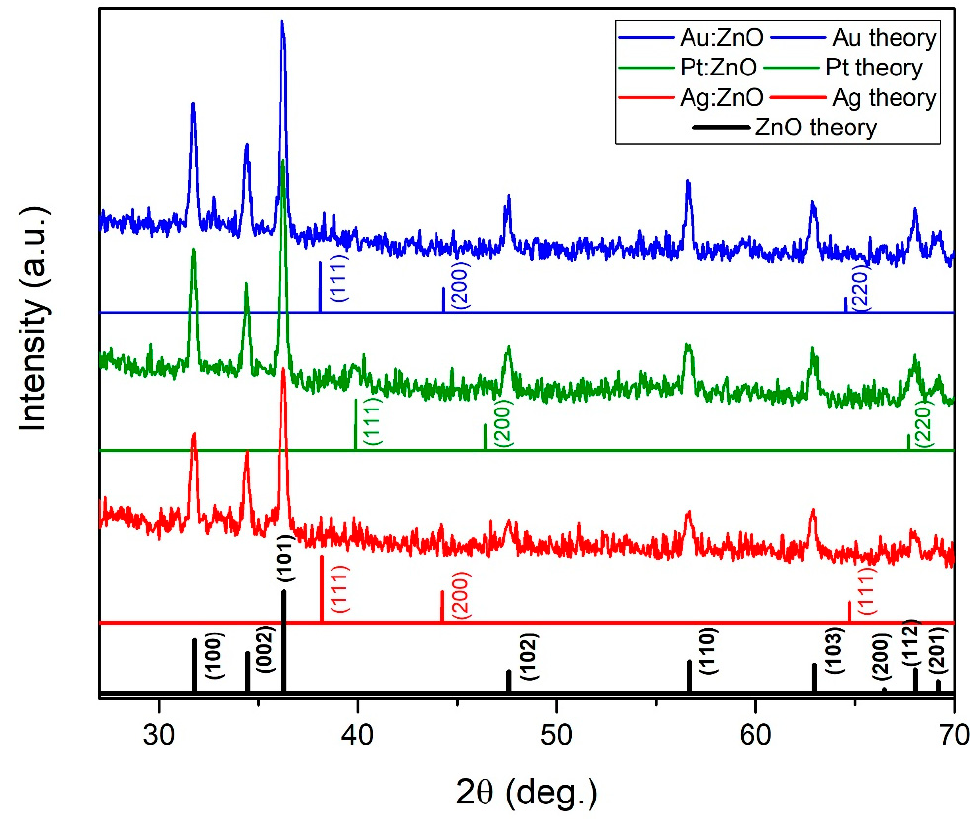
Figure 4. X-ray diffraction patterns of the Ag, Au, and Pt doped ZnO nanoparticles. We observed shifts in the peaks of the hexagonal wurtzite structure (Figure 5) into smaller angles for the Ag: ZnO, Au: ZnO, and Pt: ZnO compared to the pure ZnO. These average shifts were 0.26 ◦ for Ag: ZnO, Au: ZnO, and Pt: ZnO. These shifts toward the smaller angles are attributed to the larger ionic radii of Ag + (1.15 Å), Au + (1.37 Å), and Pt 2+ (0.8 Å) than Zn 2+ (0.74 Å), which implies that Ag + , Au + , and Pt 2+ substituted fraction of Zn 2+ ions in the ZnO lattice. The sum of ionic radii (Ag + O, Au + O, Pt + O) is greater than the sum of ionic radii of Zn and O. Also, the bond lengths of Ag-O, Au-O, and Pt-O are longer than Zn-O in a hexagonal structure. This means that the unit cell should expand, and consequently, XRD peaks shift towards smaller angles. Similarly, Anugrahwidya et al. reported a shift in the main peak towards the smaller Bragg angles when Ag atoms substituted Zn atoms [39]. According to the literature, when a dopant has a bigger ionic radius than the matrix atom, then peaks shift towards smaller angles (e.g., Fe, Mn, In) [38,55,56]. On the contrary, when a dopant has a smaller ionic radius than the matrix atom, then peaks move towards higher values (e.g., Mg, Cu, Co, Ni) [35,37,55]. Lattice constants a (for (100) plane) and c (for (200) plane) can be calculated using the following formulae [54]: